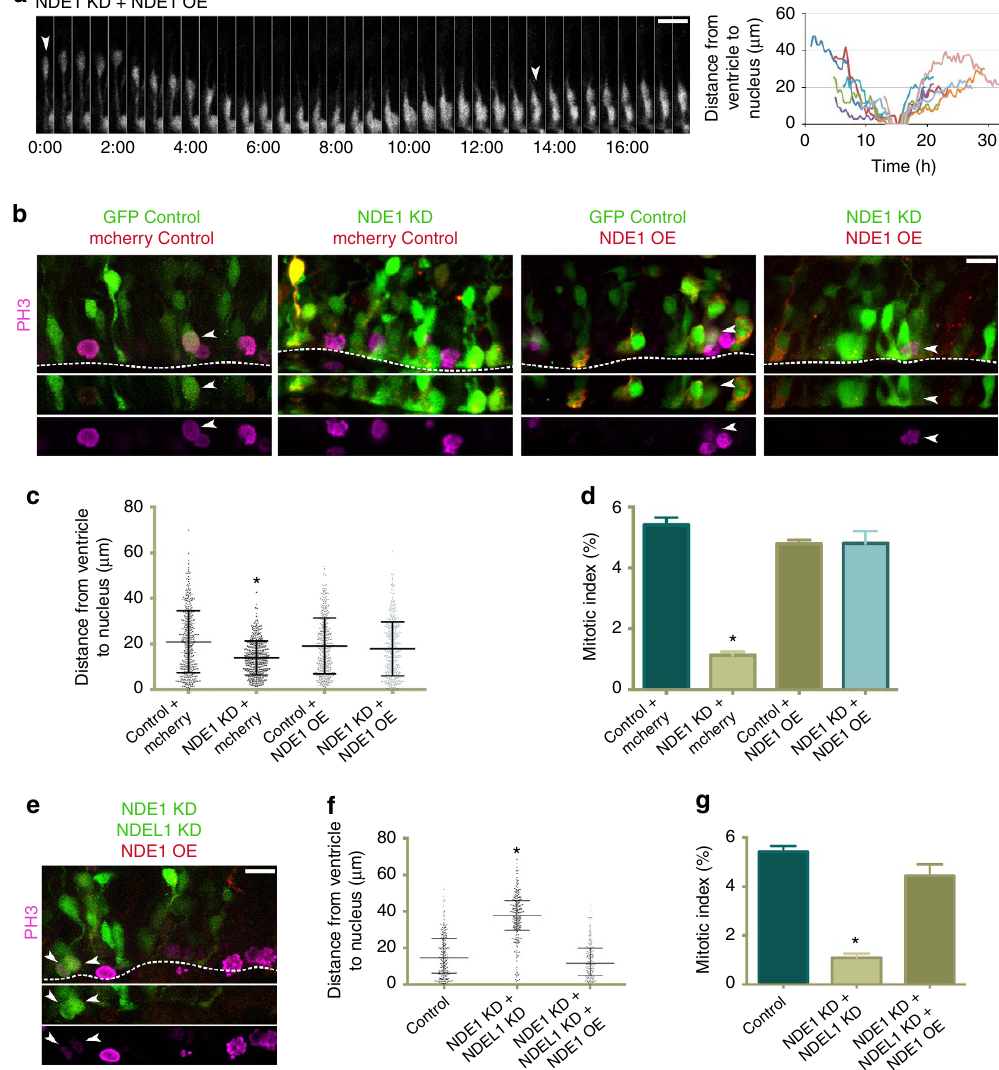
Figure 6 | RNAi-resistant NDE1 overexpression rescues all defects seen in radial glia progenitors across knockdown conditions. RNAi-resistant NDE1 was co-electroporated into embryonic rat brains with a GFP control empty vector or along with NDE1 shRNA or NDE1 and NDEL1 shRNAs at E16, and analysed at E20. ( a ) Restoration of apical interkinetic nuclear migration, mitosis and subsequent basal migration of progeny measured by live imaging. Arrowheads marks the radial glia progenitor (RGP) of interest. Montage panels are shown at 30min intervals. Full movie can be found in Supplementary Material (see Supplementary Movie 5), as well as an additional movie that more clearly displays the two-daughter cell progeny (Supplementary Movie 6). ( b ) Representative images of RGPs stained for PH3 within the VZ in various specified co-expression conditions. Arrowheads mark mitotic electroporated RGPs. Dashed line indicates ventricular surface. ( c ) Soma position of RGPs with RNAi-resistant NDE1 overexpressed during NDE1 knockdown indicates that the somal positioning distribution is rescued. ( d ) Overexpression of RNAi-resistant NDE1 with NDE1 knockdown also rescues the mitotic index. ( e ) Representative image of NDE1/NDEL1 double knockdown with overexpression of RNAi-NDE1, stained for PH3. Arrowheads mark mitotic electroporated RGPs. Dashed line indicates the ventricular surface. ( f , g ) Overexpression of RNAi-resistant NDE1 with double NDE1/NDEL1 knockdown rescues the distribution of RGP nuclei in the VZ and restores the mitotic index of RGP cells. Data are presented as scatterplot in c and f with bars representing the median ± the interquartile range, and as mean ± s.e.m. in d and g ). Kolmogorov–Smirnov test for non-parametric distributions used in c and f (* P o 0.05, n ¼ 428–474 RGP cells in c and n ¼ 224–260 RGP cells in f ). Unpaired t -test used in d and g (* P o 0.05, n ¼ 3 embryonic brains from different mothers). Scale bars, 10 m m. Also see Supplementary Fig.